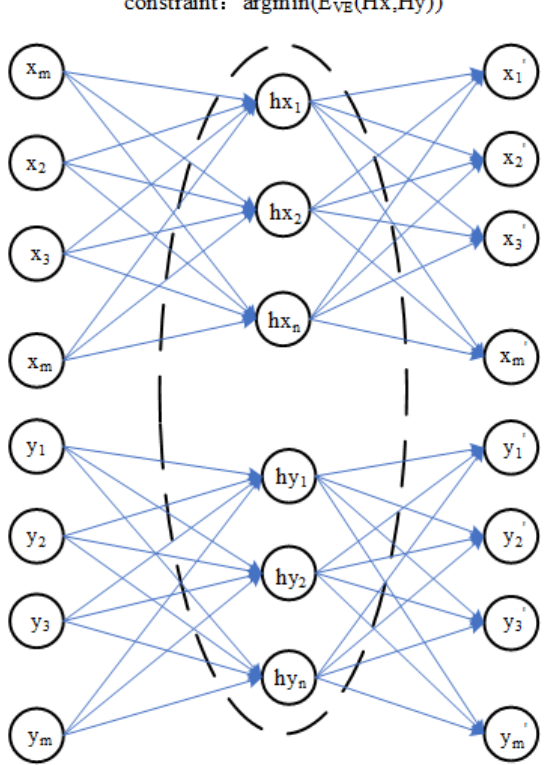
Figure 2. Training process of a model transfer algorithm based on a deep autoencoder.